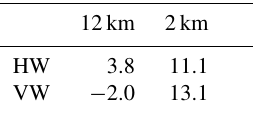
Table 3. Changes in the ToA energy budget (OLR plus RSR) with surrogate warming compared to CTRL in Wm − 2